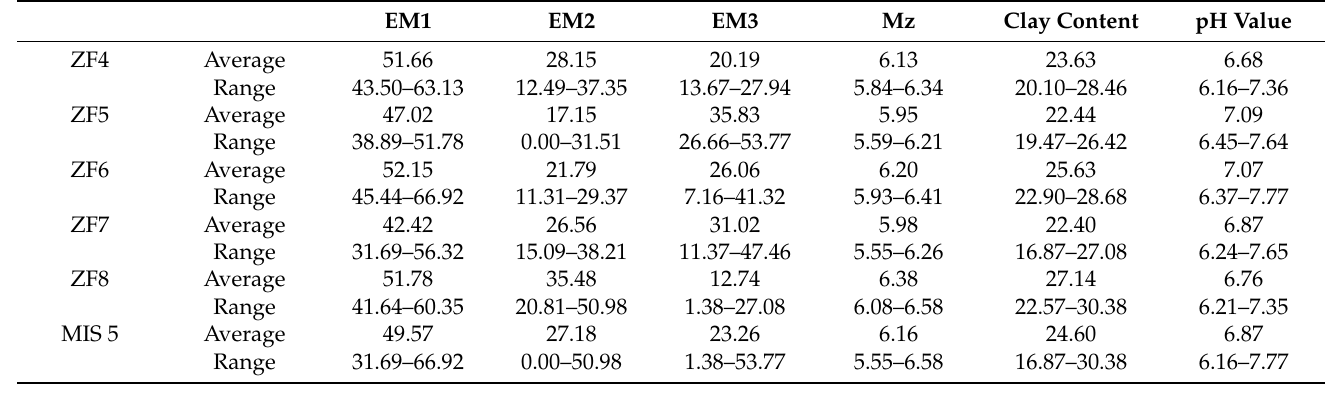
Table 4. Average values and distribution ranges of climate indices of the last interglacial period in the ZFS.